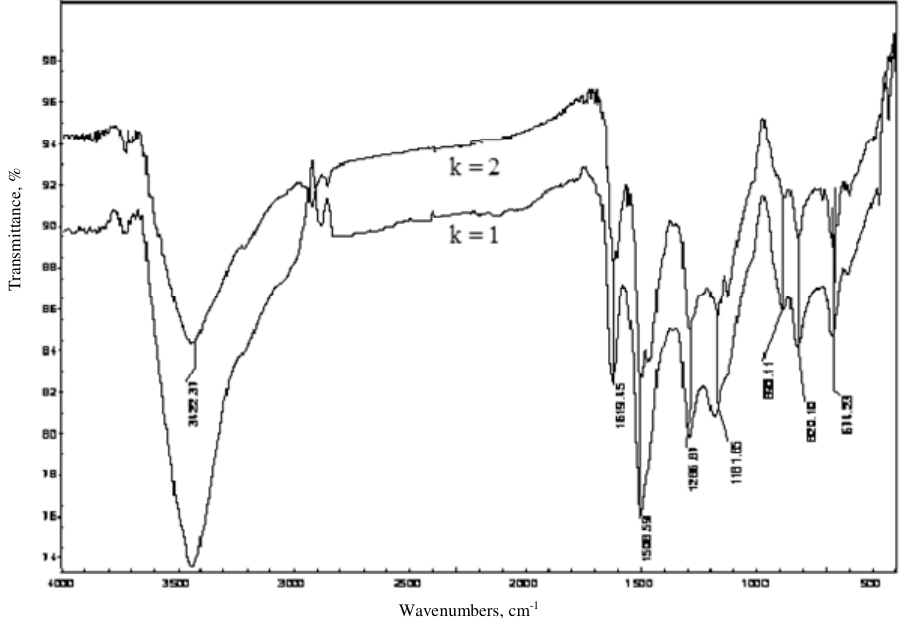
Figure 2. IR spectra of the formed product with different value of